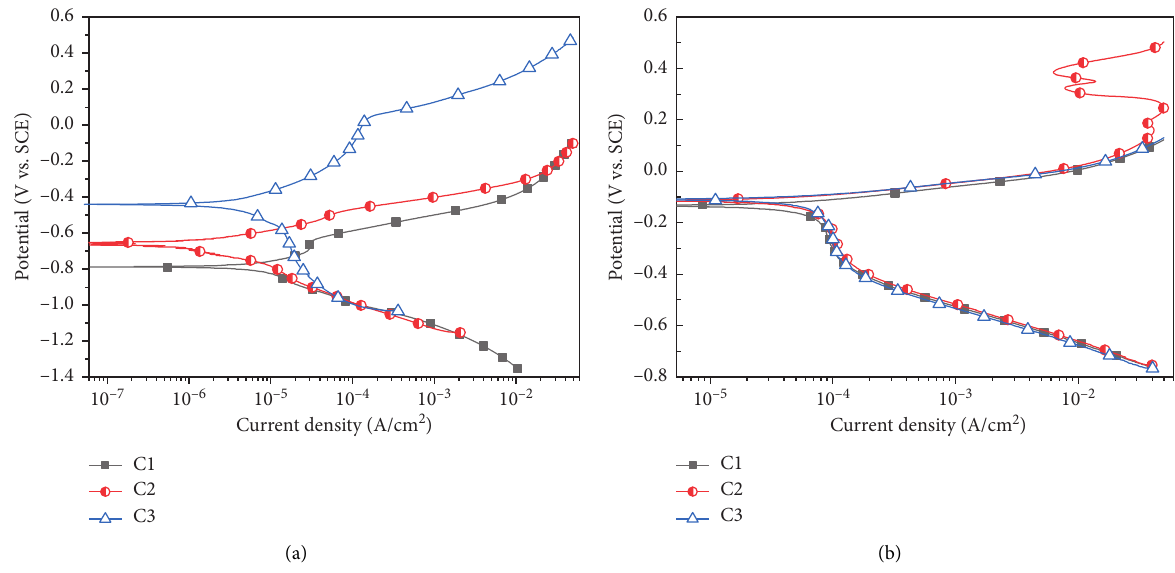
2 SO 4 solutions.